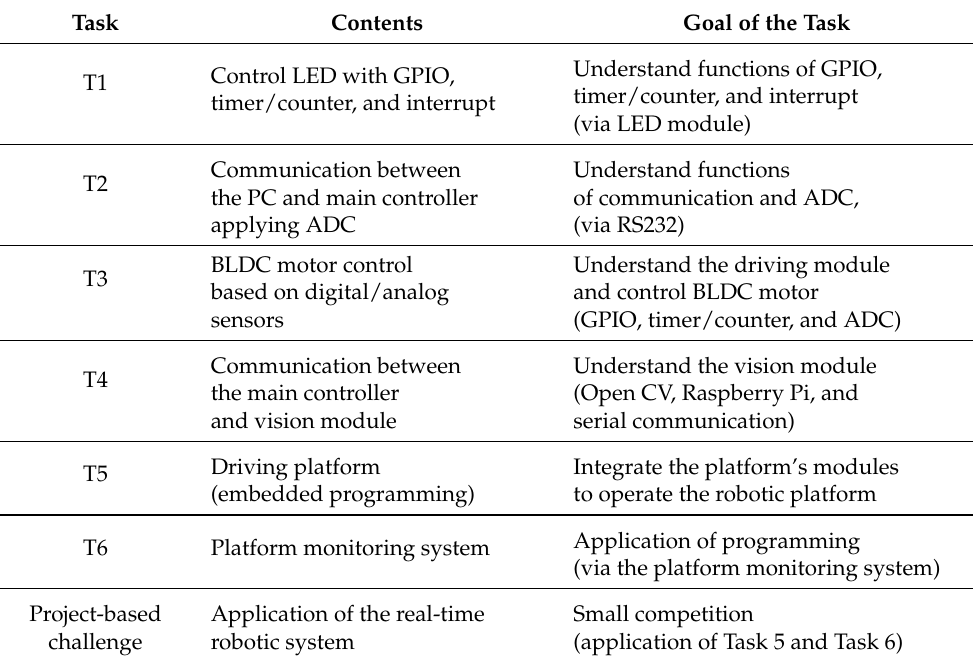
Table 4. Details of the assignment and